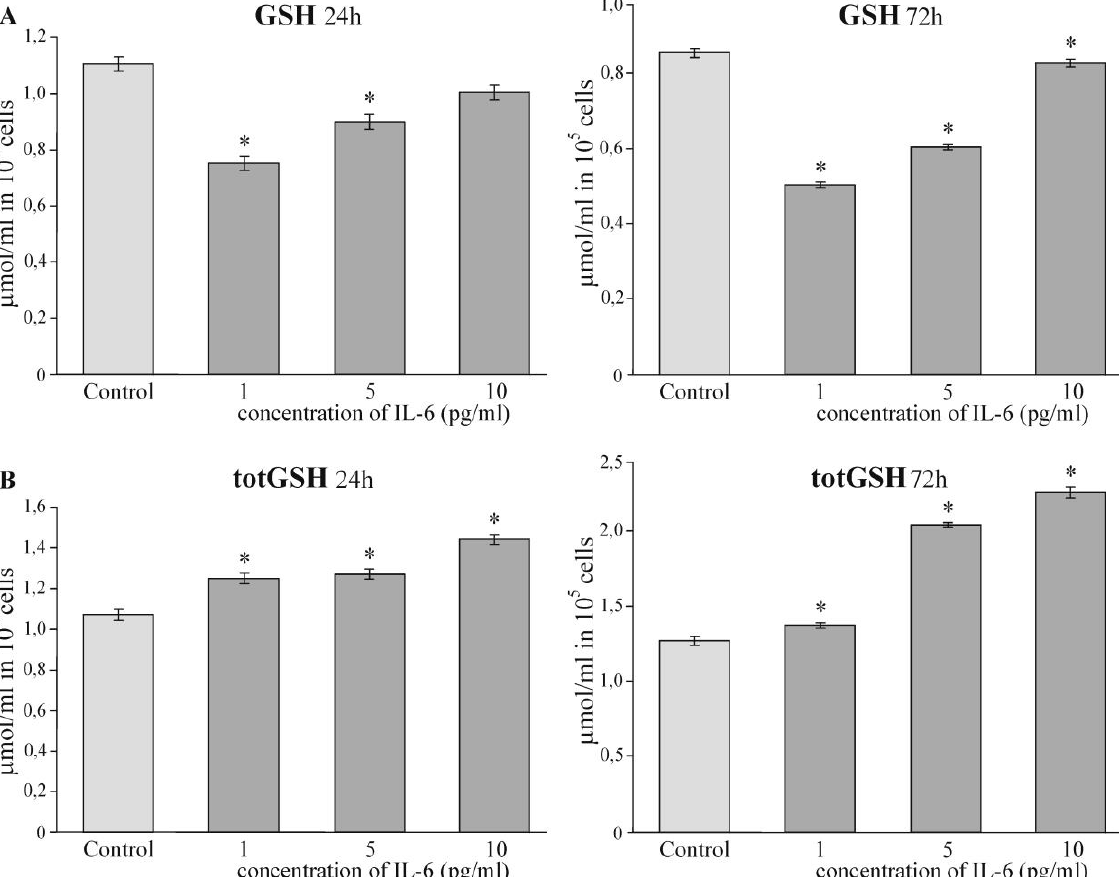
Figure 3. The effects of IL-6 on concentration of GSH (A) and totGSH (B) in JEG-3 cells after 24 h and 72 h of treatment under chemically induced hypoxia. Results are presented as the mean of three independent experiments ± standard error * p <0.05 relative to